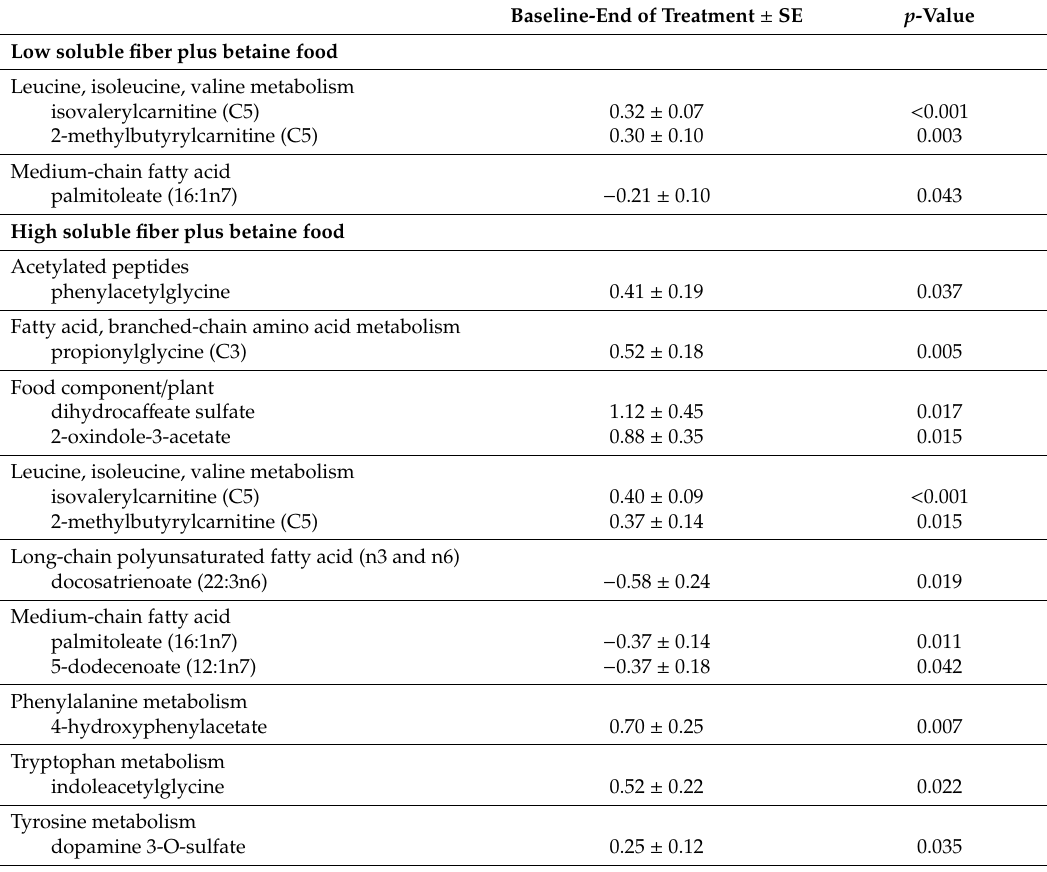
Table 4. Di ff erences from baseline in log-transformed data of plasma metabolites in dogs with early renal disease who consumed the low soluble fiber plus betaine and high soluble fiber plus betaine foods. Baseline-End of Treatment ± SE p